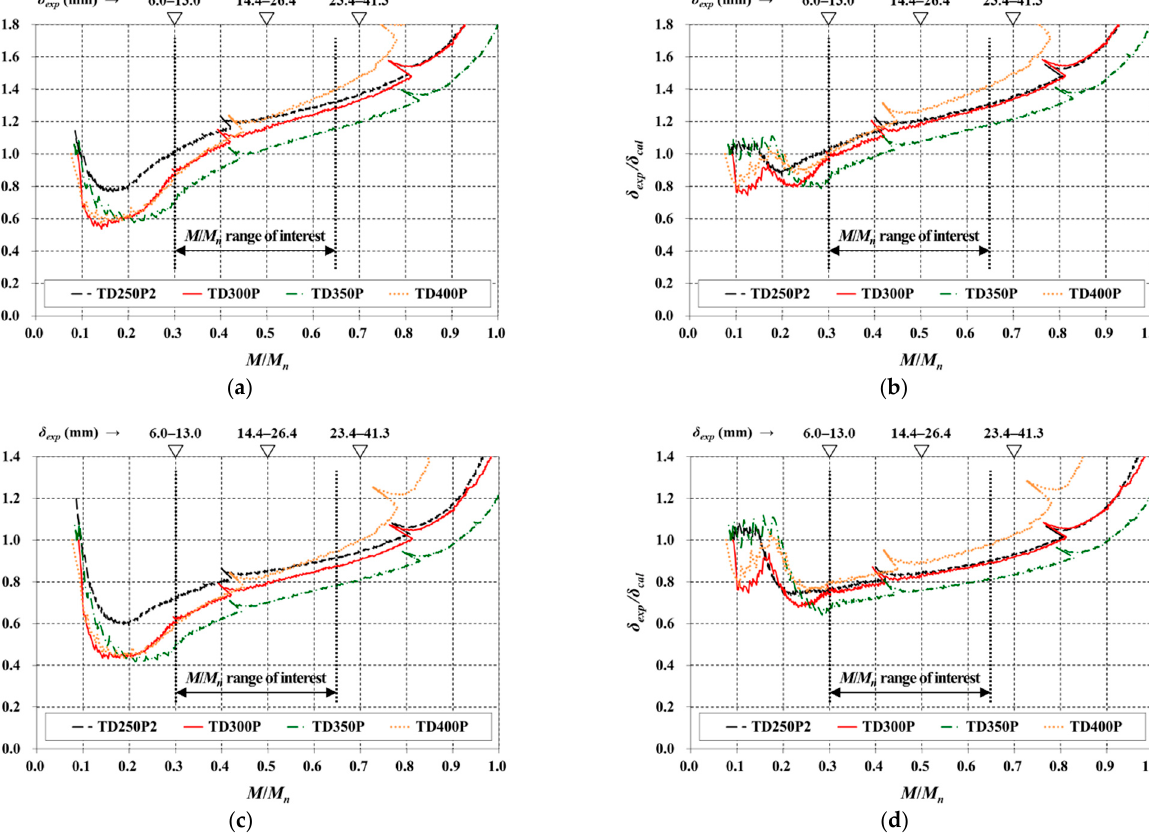
Figure 8. Comparison of immediate deflection (TD slabs with a variable of slab thickness): ( a ) 0.5 f r and full contribution conditions; ( b ) f r and full contribution conditions; ( c ) 0.5 f r and half contribution conditions; ( d ) f r and half contribution conditions.